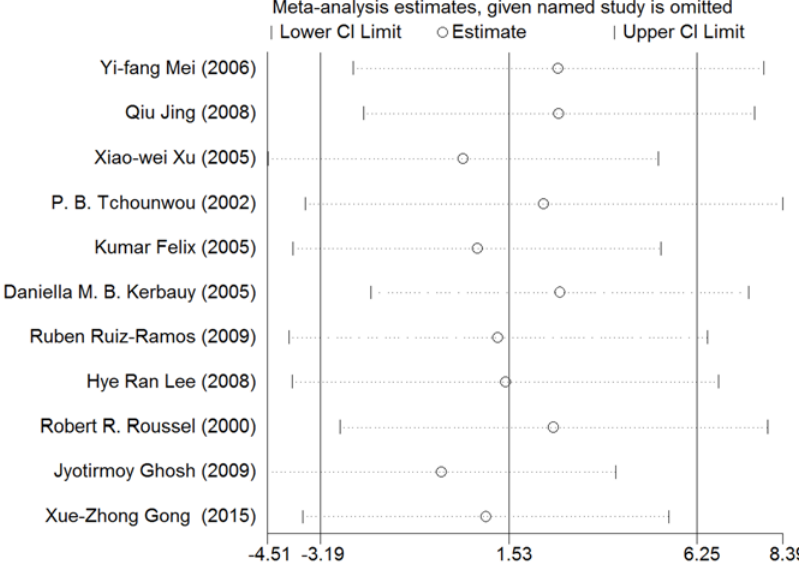
Figure 13. Sensitivity analysis for NF ‐κ B. Stable results were observed for all studies, indicating that no individual study influenced the combined results. Abbreviations: CI = confidence interval.